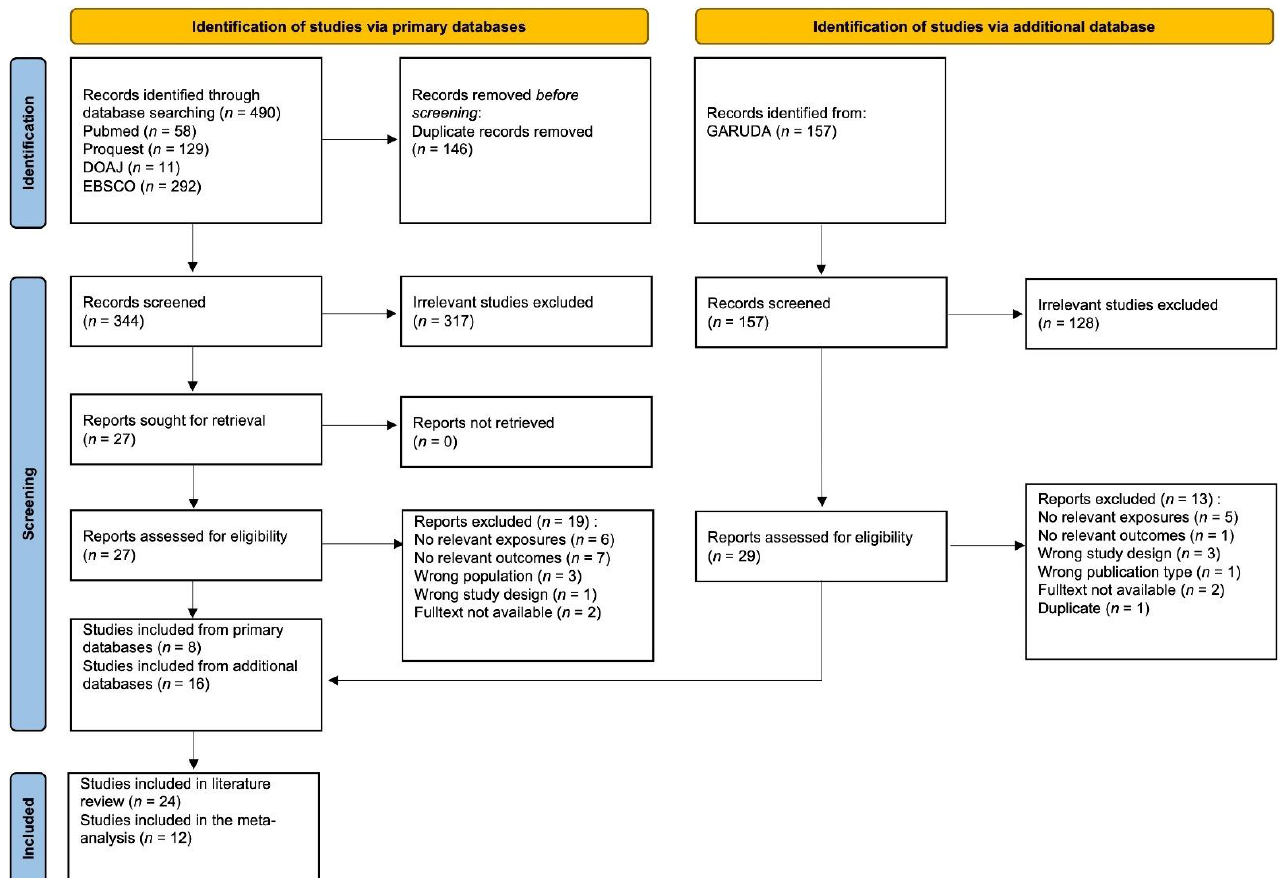
Figure 1. Data collection